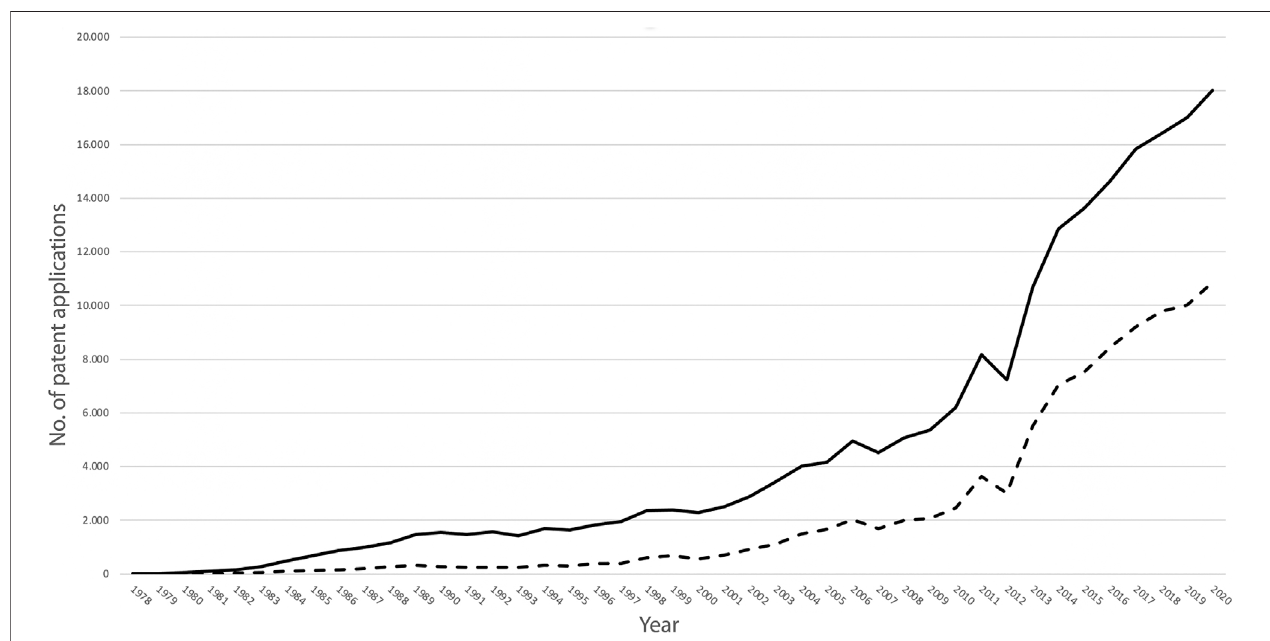
FIGURE 1 | Number of patent applications for the period 1978-2020 for inventions based on monoclonal antibodies (continuous line) and for inventions based on monoclonal antibodies intended for the oncology sector (dotted line) (Graph based on data of the European Patent Of fi ce, 2021).